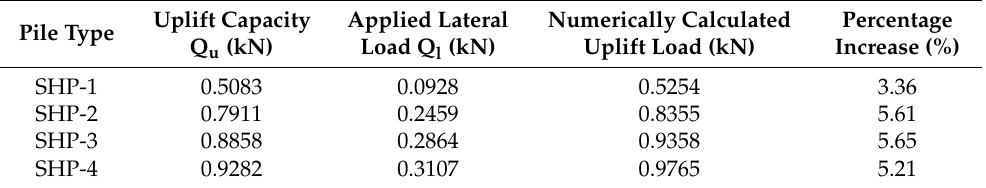
Table 5. Ultimate uplift capacity with and without lateral load.